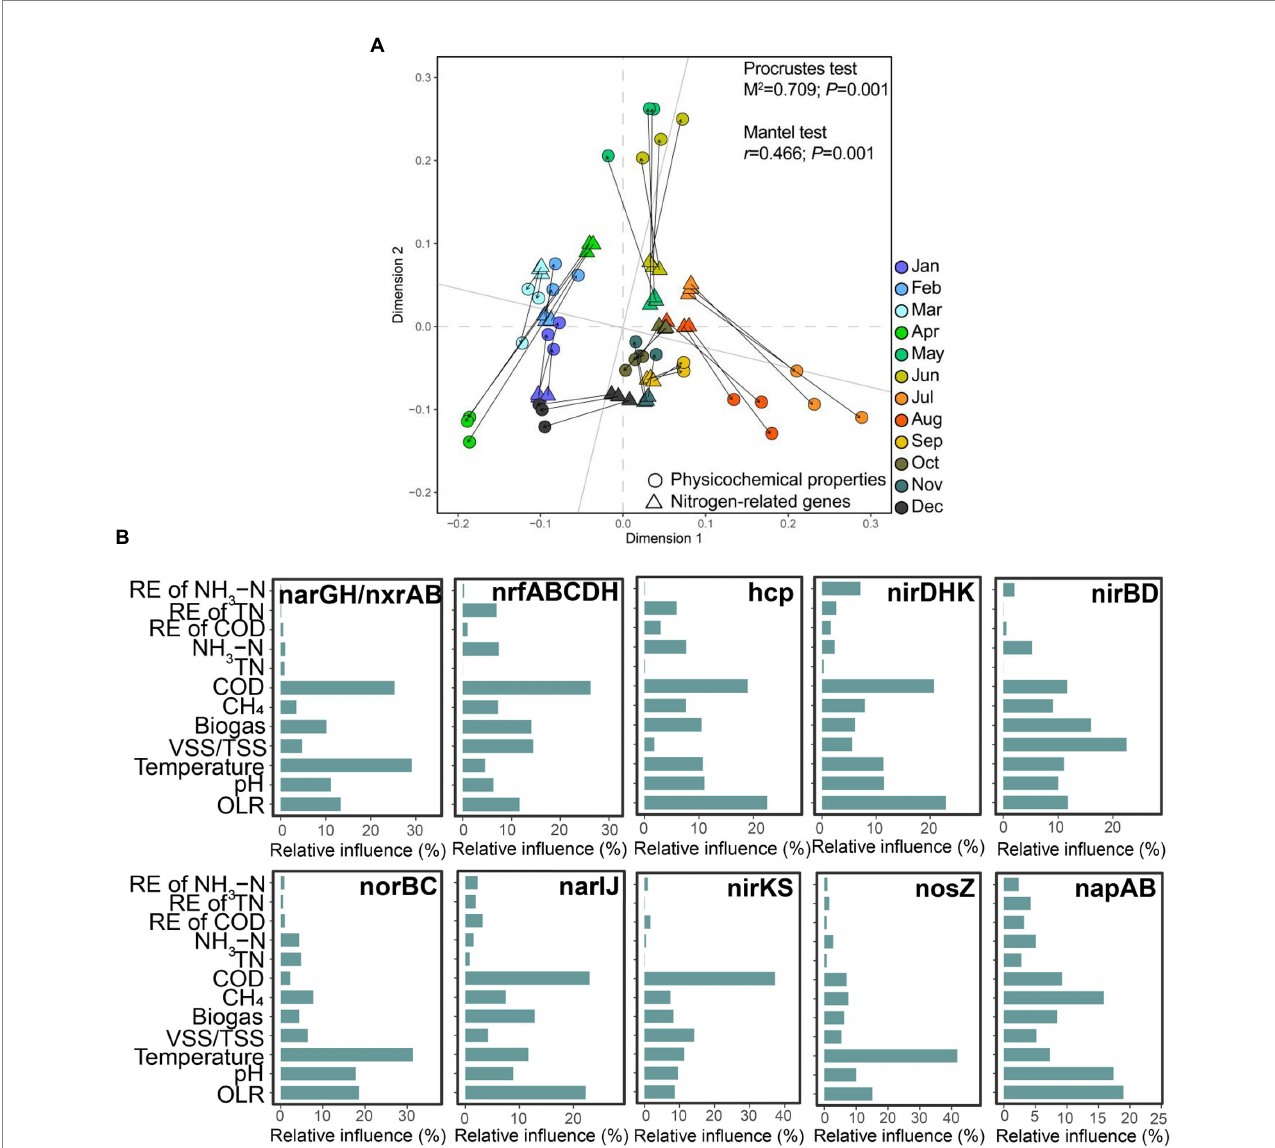
FIGURE 4 Correlation between the physicochemical properties and the nitrogen-related genes. (A) Procrustes analysis of the changing physicochemical properties and the abundance of nitrogen-related genes. Both the Procrustes test and the Mantel test are used for evaluating whether the association is significant and p < 0.05 is considered a significant correlation. (B) The relative contributions of different physicochemical properties to the top 10 highly abundant genes are determined by GBM